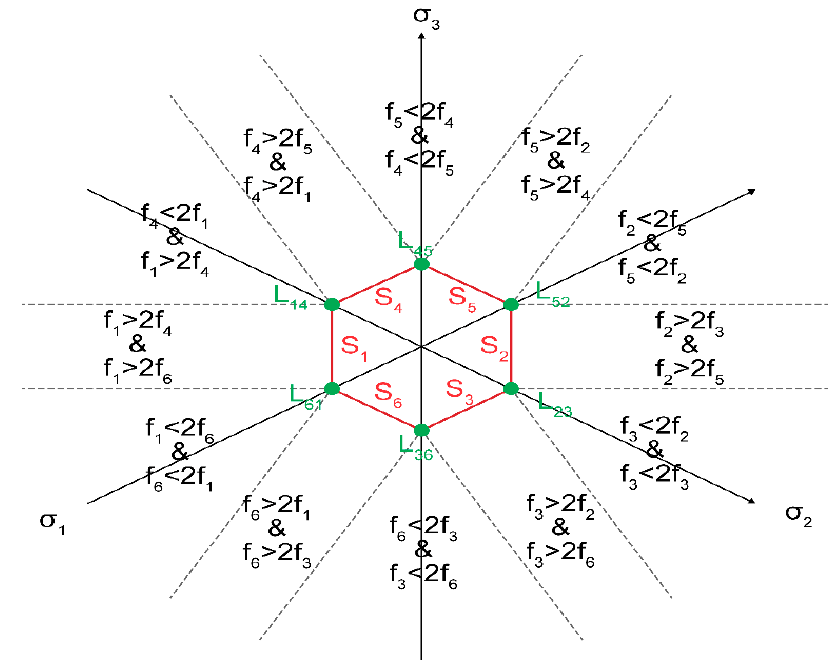
Figure 4. Plane surfaces from the Tresca yield surface [23].